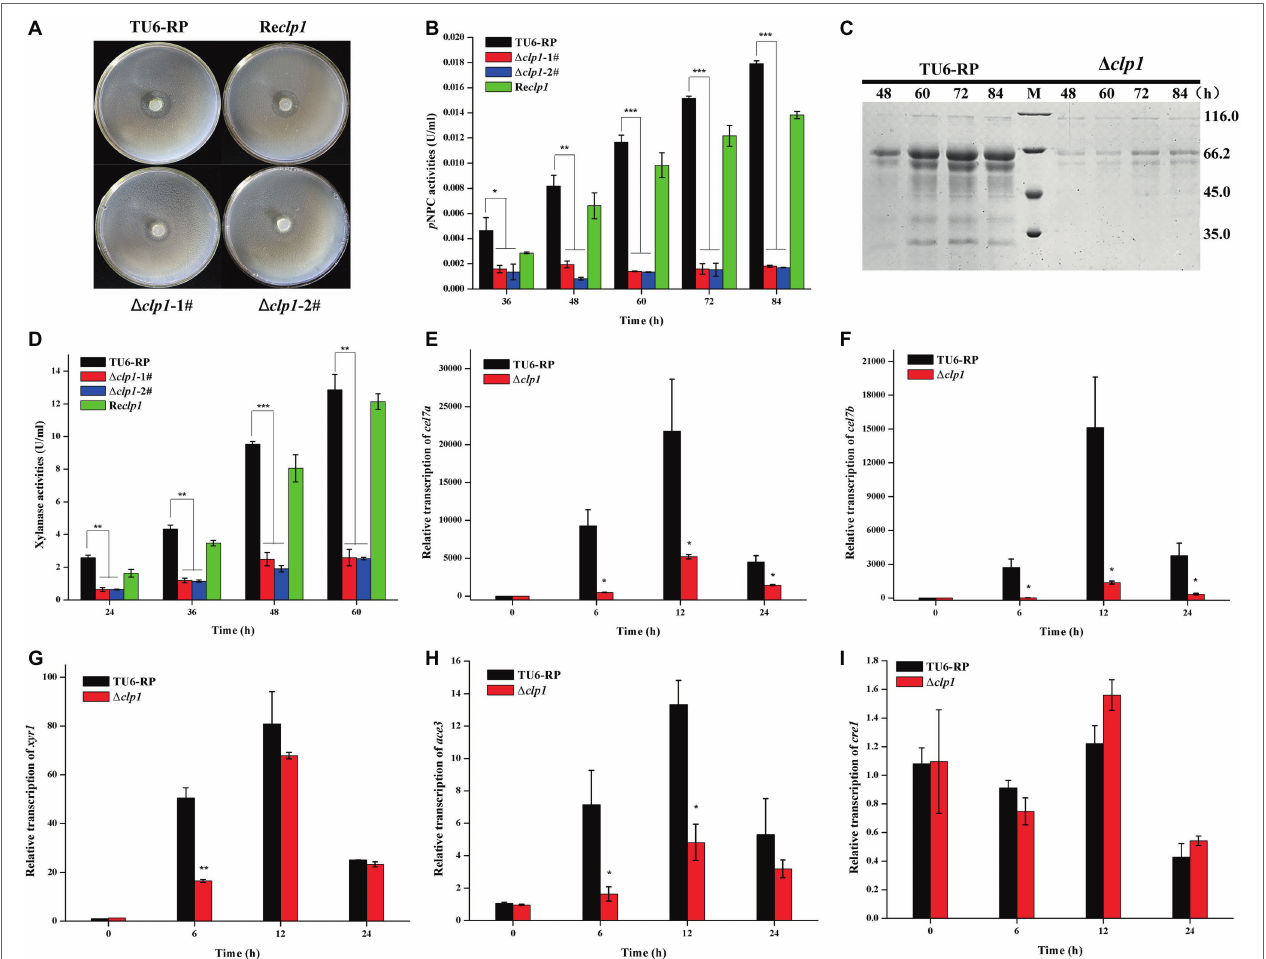
FIGURE 3 | Absence of CLP1 compromises induced (hemi)cellulase gene expression. (A) Hydrolytic zone formation of Δ clp1 , Re clp1 , and TU6-RP strains on solid plate covered with a layer of 0.4% (w/v) ground Avicel. (B) Extracellular p NPC hydrolytic activities of the culture supernatant from Δ clp1 , Re clp1 , and TU6-RP strains cultured on 1% (w/v) Avicel. (C) SDS-PAGE analysis of the culture supernatant from TU6-RP and Δ clp1 strains cultured on 1% (w/v) Avicel. (D) Extracellular xylanase activities of the culture supernatant from Δ clp1 , Re clp1 , and TU6-RP strains cultured on 0.5% (w/v) xylan. (E–I) Analyses of relative transcriptional levels of cel7a (E) , cel7b (F) , xyr1 (G) , ace3 (H) , and cre1 (I) in the Δ clp1 and TU6-RP strains cultured on 1% (w/v) Avicel using quantitative RT-PCR. Significant differences ( t test, * p < 0.05, ** p < 0.01, *** p < 0.001) were observed in the phenotypes as indicated between the control strain TU6-RP and the Δ clp1 strain. Values represent the mean of three biological replicates. Error bars are the SD from these